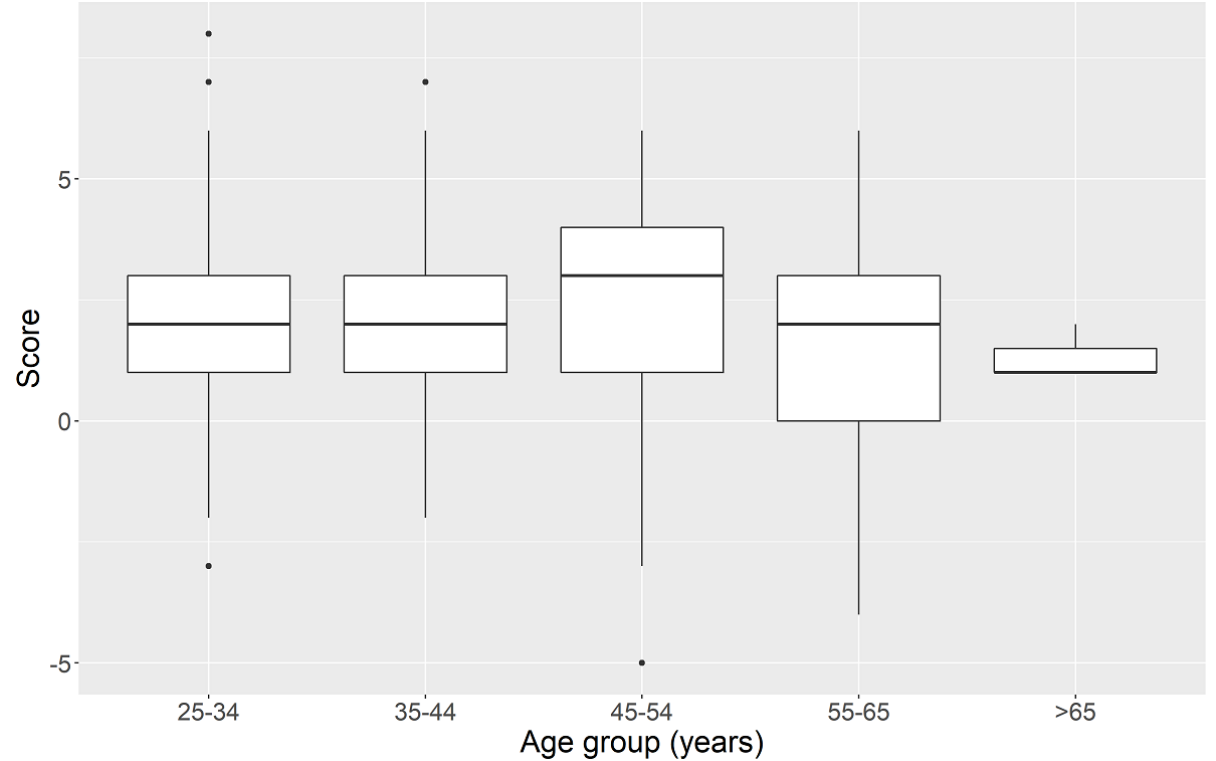
Figure 3. Attitude toward mobile devices stratified by age